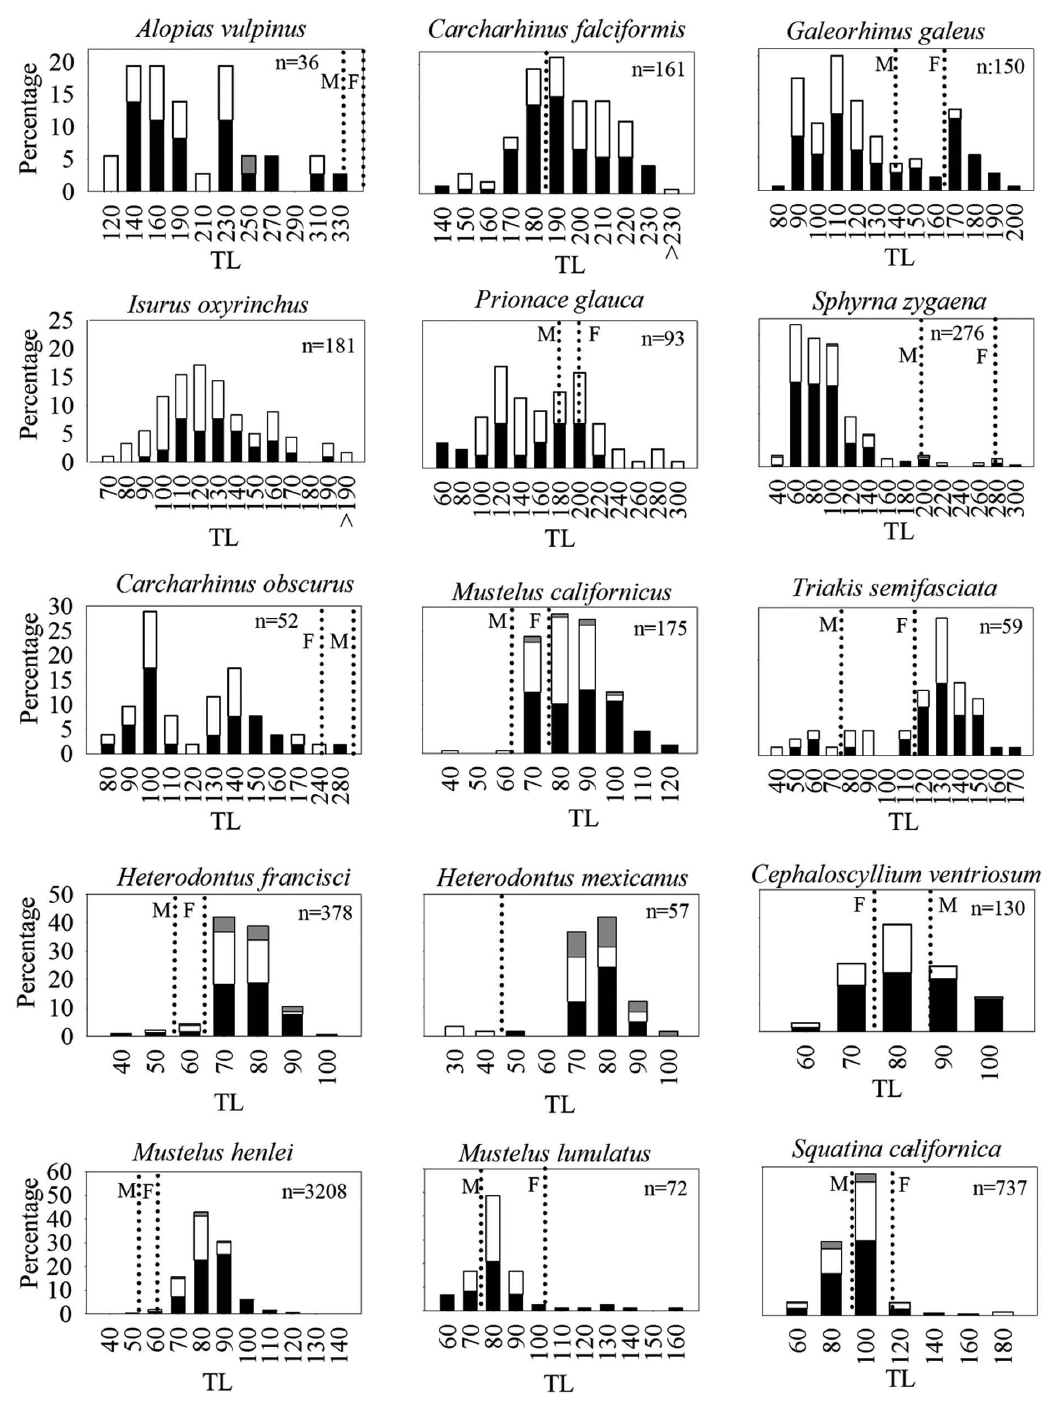
Fig . 2. – Size frequency distributions by sex of shark species captured by gillnets. n refers to the number of measured individuals. Females are depicted in black, males in white, unsexed specimens in grey. Dotted lines indicate the size at maturity. In cases in which a substantial difference in size at maturity exists between sexes, lines are labeled M (male) or F